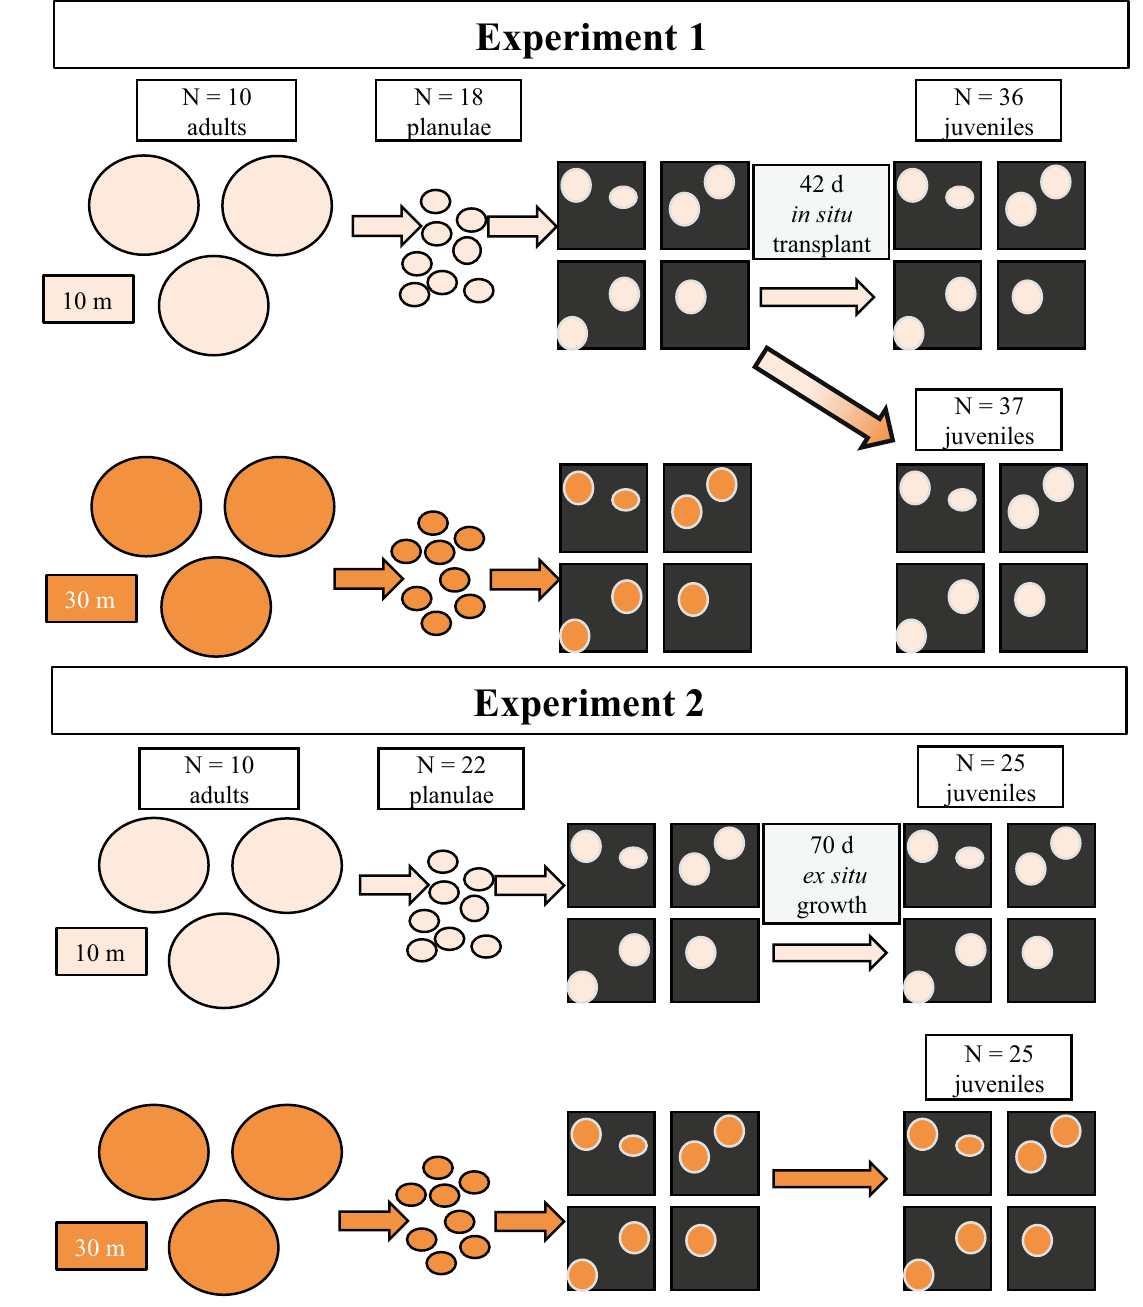
Fig 2. Flow-through of experimental design for experiments 1 and 2. In Experiment 1, Symbiodinium consortia were determinedfor shallowand upper mesophotic Porites astreoides adult coloniesand planulae.Juvenilesof shallowparental origin were reared in situ on the shallowand upper mesophoticreef and were examinedfor specific growth rates and Symbiodinium phylotypecombinations. In Experiment 2, Symbiodinium consortiaand specific growth rates were determined for shallow and upper mesophoticplanulaeand ex situ reared